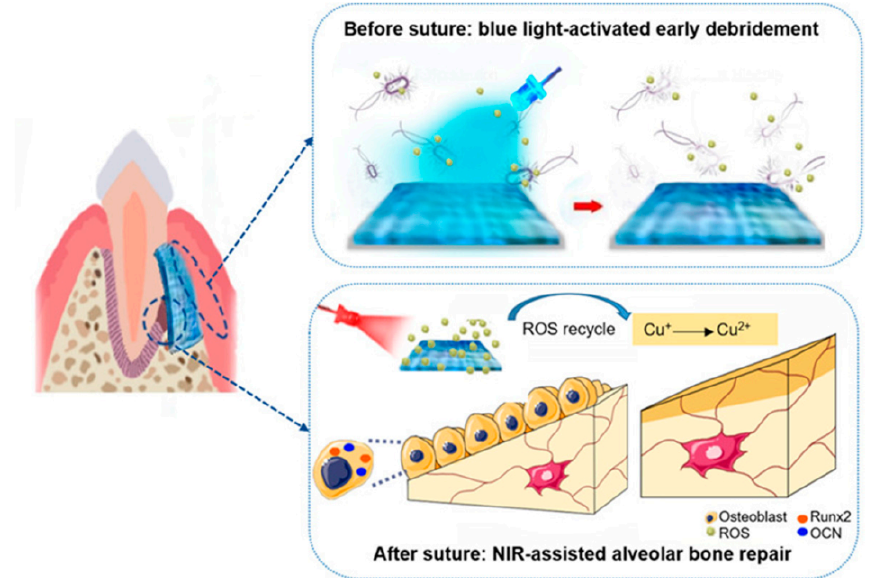
Figure 5. Jelly-inspired injectable hydrogel composite materials for guided tissue regeneration strategies. Before suture, under blue light excitation, sodium alginate hydrogel composite (CTP-SA) was activated to produce ROS to kill bacteria, achieving early debridement. After suture, under NIR irradiation, the photothermal effect of CTP-SA via the ROS recycle promote the osteogenesis (Reprinted with permission from Yingying Xu, Siyu Zhao, Zhenzhen Weng, Wei Zhang, Xinyi Wan, Tongcan Cui, Jing Ye, Lan Liao, and Xiaolei Wang ACS Applied Materials and Interfaces 2020 12 (49), 54497–54506 DOI: 10.1021/acsami.0c18070. Copyright 2020)